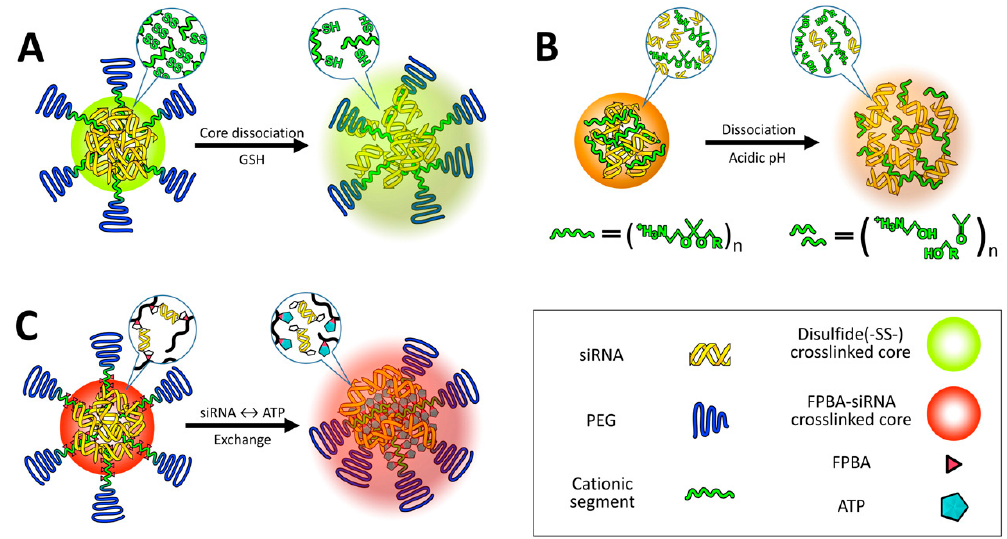
Figure 6. Multimolecular structures introduce redox-responsive thiol bonds in the core region ( A ); Delivery vehicle contains acidic pH responsiveness for faster dissociation ( B ) and introduce ATP-responsiveness in the core region for selective dissociation ( C ) (Reproduced with permission from [18].